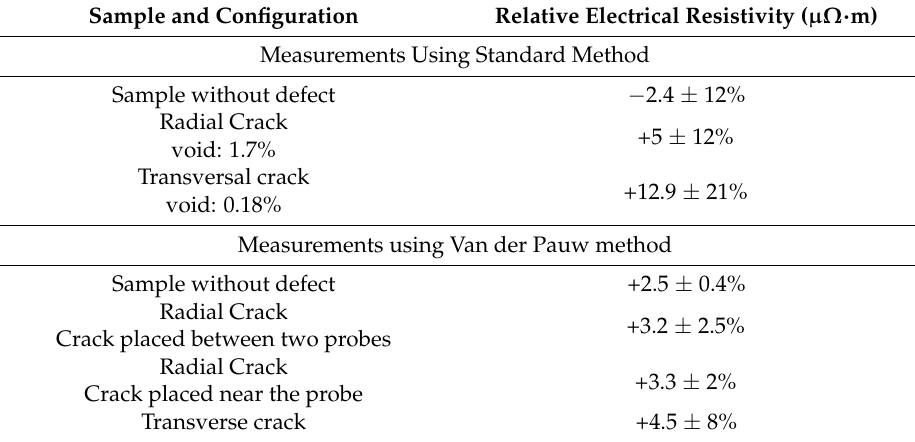
Table 1. Electrical resistivity measurement of samples containing defects using both the standard and the Van der Pauw